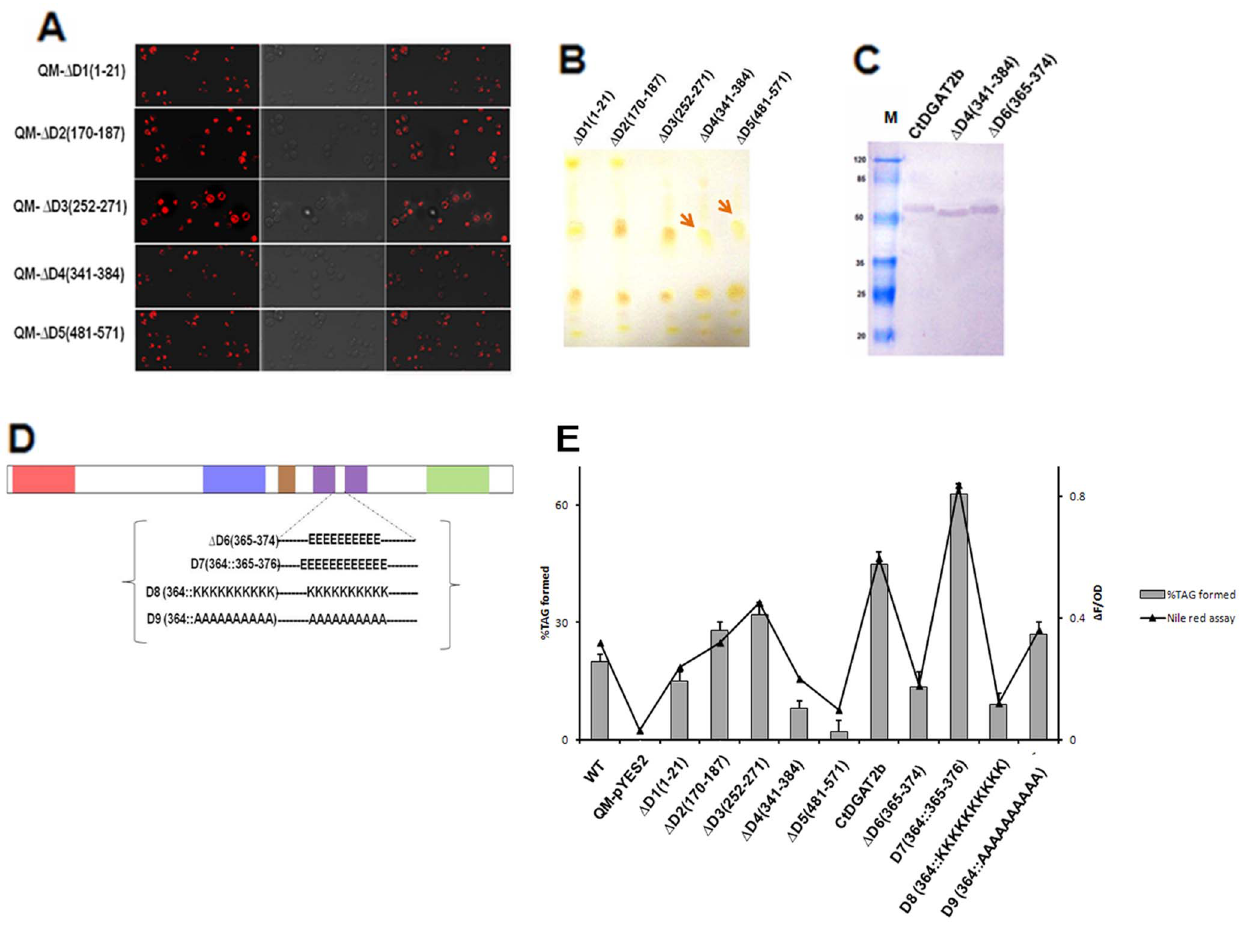
Figure 7. Differential enzymatic activity of various mutated versions of the CtDGAT2b towards TAG formation in S.cerevisiae QM strain. (A) Nile red fluorescence confocal microscopy showing lipid body formation is restored in yeast QM cells albeit at different extent, upon expression of five deletion mutants of CtDGAT2b. (B) Differential complementation of the TAG-deficient phenotype of the yeast QM strain by enzymatic activities of five deleted constructs D D1(1–21), D D2(170–187), D D3(252–271), D D4(341–384) and D D5(481–571). Neutral lipid fractions were separated by TLC, and lipid spots were visualized as described in experimental methods. (C) Western blot showing the recombinant proteins of 60–63 kDa produced upon galactose induction of yeast QM cells transformed with the recombinant pYES2/CT plasmid carrying either the full length CtDGAT2b gene or the mutant D D4(341–384) or D D6(365–374) version. Immunodetection was carried out with mouse anti-His monoclonal antibody. (D) Schematic diagram showing the insertion and replacement of amino acids at a unique polyglutamic acid stretch of ten residues in the segment D D4(341–384) created mutants D7(364::365–376), D8(364::KKKKKKKKKK) and D9(364::AAAAAAAAAA). (E) Bar and line diagrams representing gravimetric measurement and Nile red fluorescence assay of lipid content in QM cells after expression of the full length CtDGAT2b and all the five deletion, one insertional and two replacement mutants; along with the WT and QM cells transformed with the non-recombinant plasmid as positive and negative controls, respectively. Fluorescence was measured at the stationary phase using 485nm (excitation) and 540 nm (emission) before and after the addition of Nile red dye, and expressed in arbitrary unit.